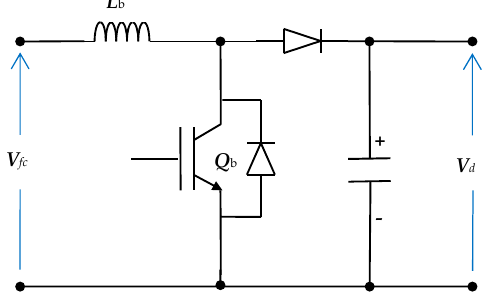
Figure 3. The boost circuit diagram.